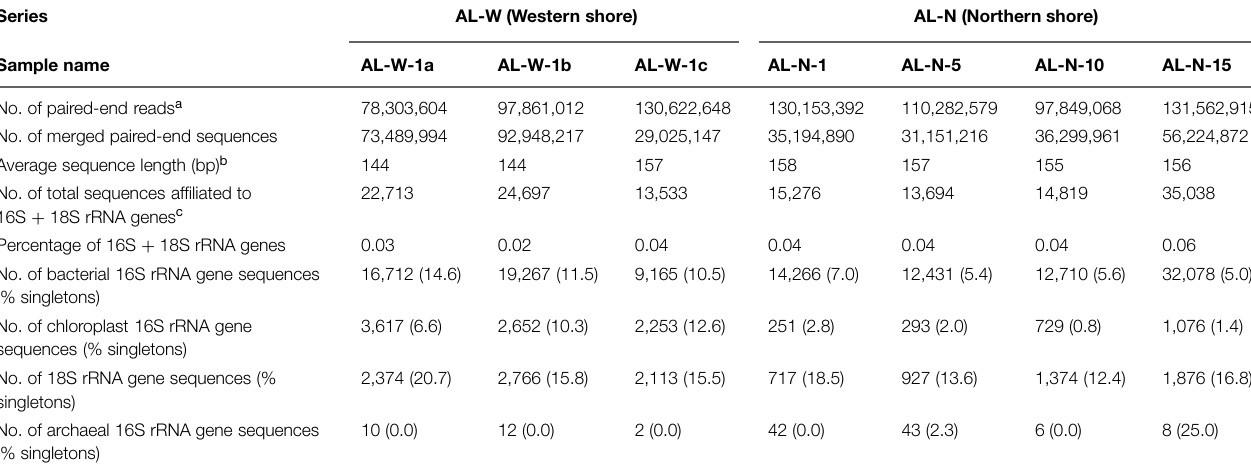
TABLE 2 | Sequence data obtained for the different Alchichica microbialite